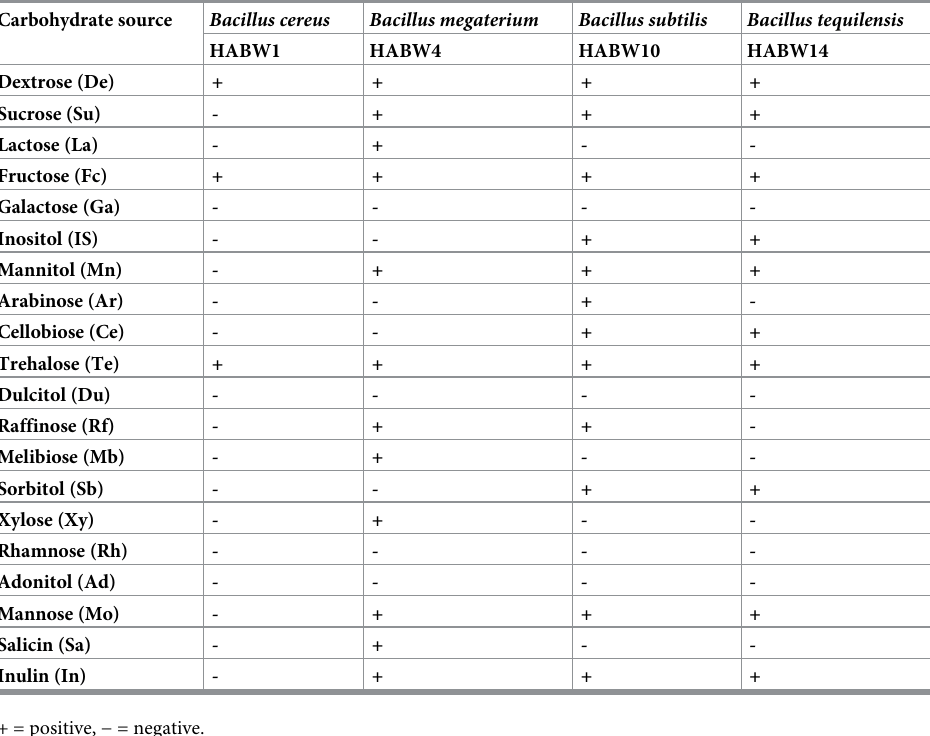
Table 9. Carbohydrate fermentation test of oviposition attractant bacterial